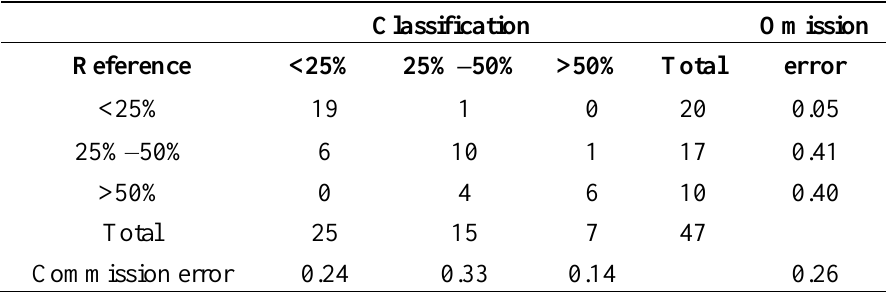
Table 3. Confusion matrix, model A (NDVI).